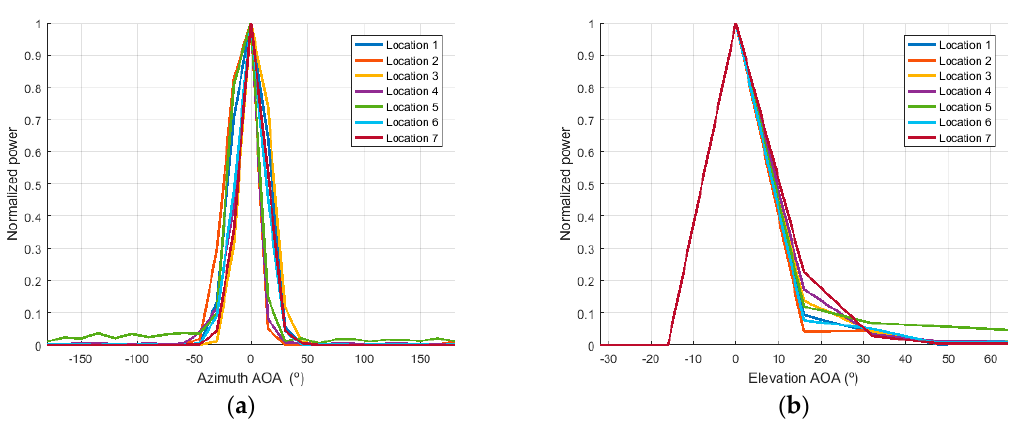
Figure 6. Angular power distribution ( APDs) for open environment ( a ) azimuth and ( b ) elevation.